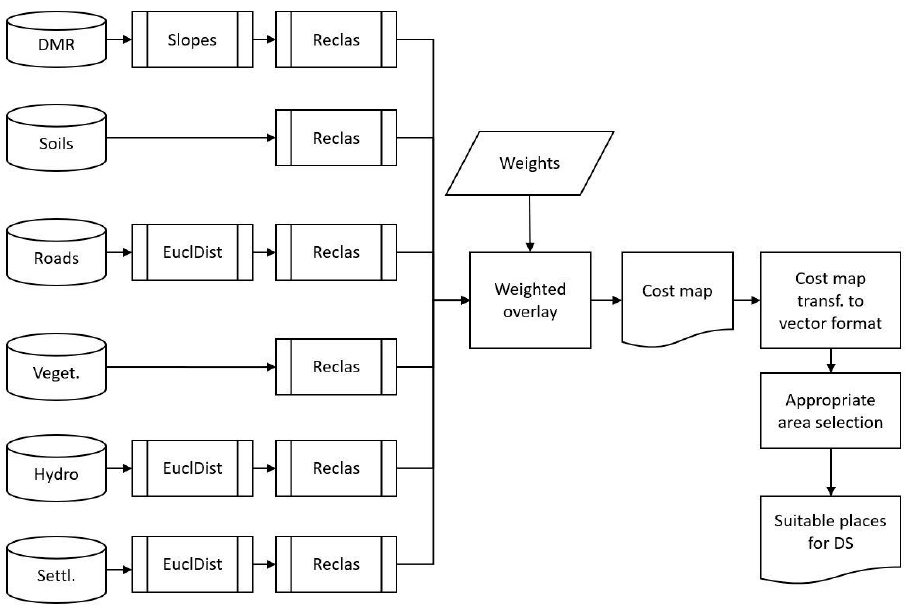
Figure 5. Flow chart of the whole process.